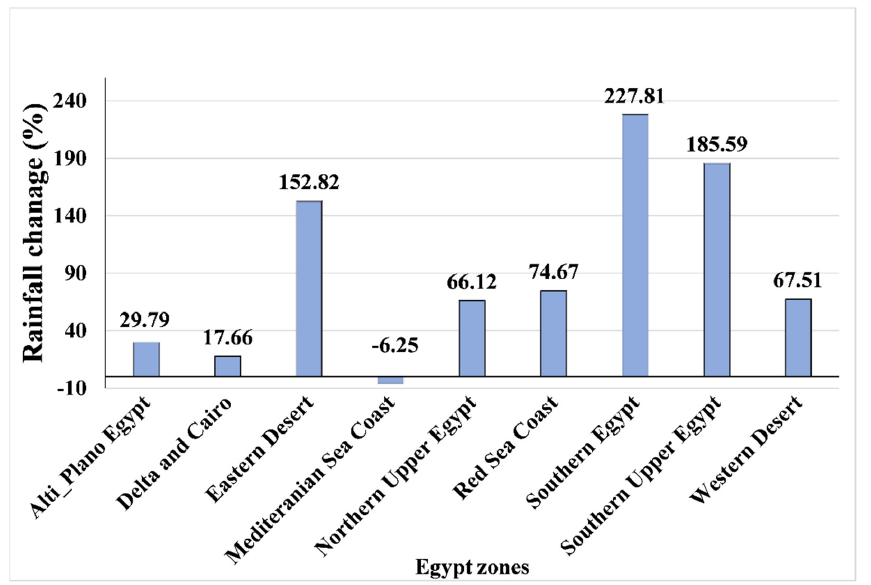
Figure 5. The zonal rainfall changes in Egypt between the past period (1950–2014) and the future period (2015–2099), considering only the months from March to May.